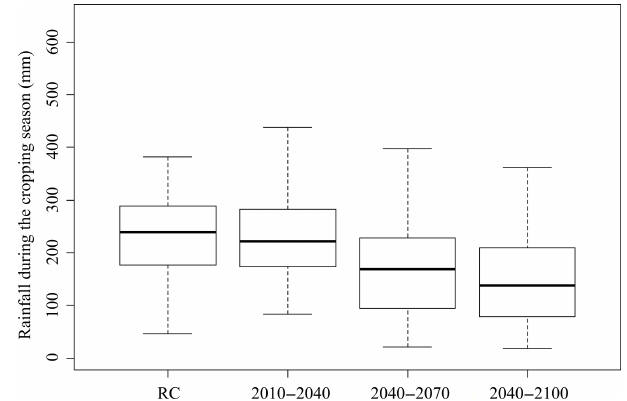
Figure 3. Cumulated rainfall during the maize growing season (April–August) in the four climate